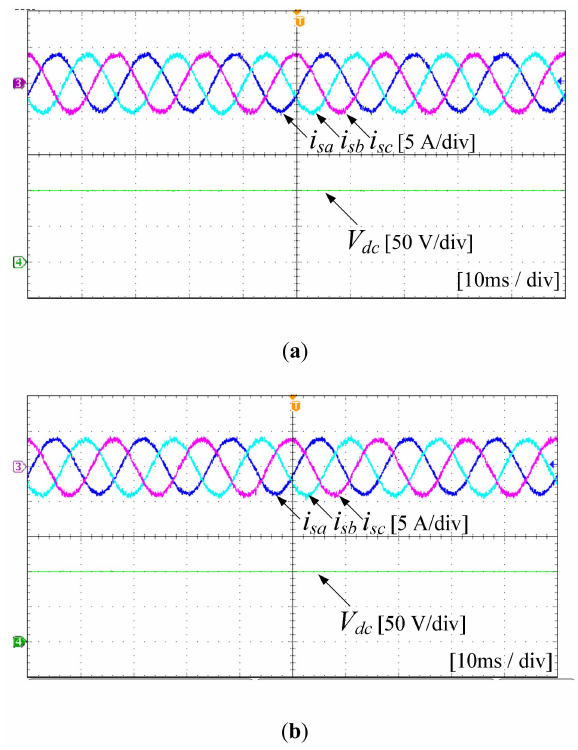
Figure 12. Experimental waveforms of the three-phase source currents and the output voltage obtained from ( a ) the conventional algorithm and ( b ) the proposed